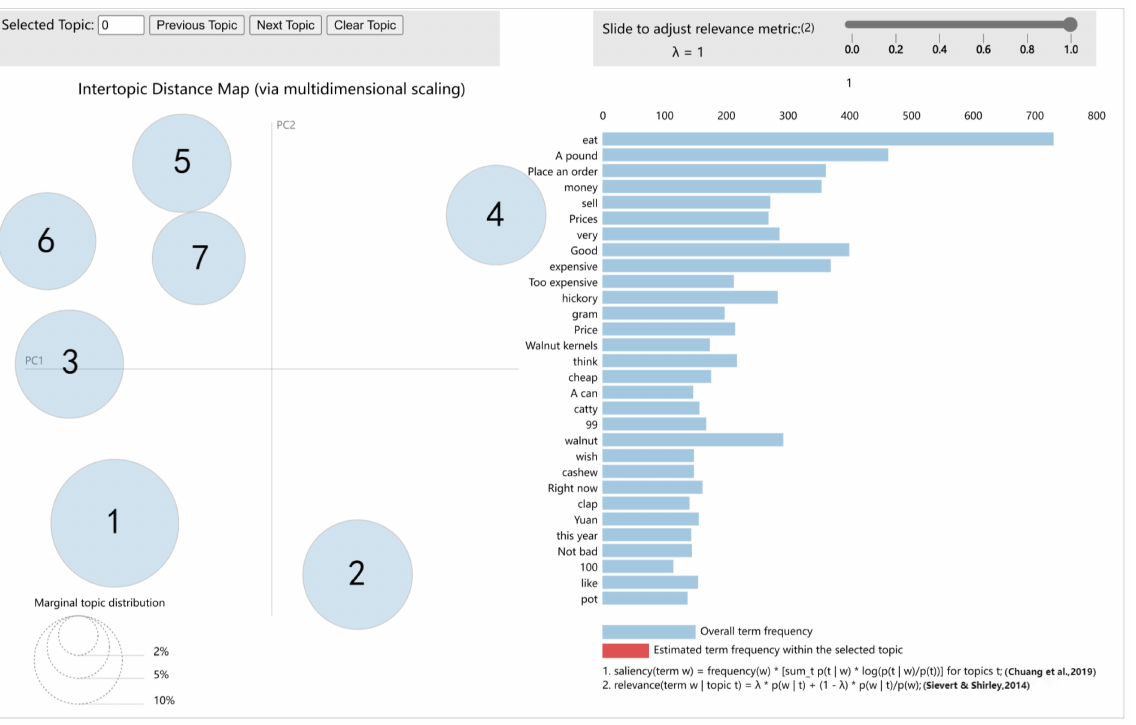
Figure 5. Best topic visualization. (In the figure, formula 1 refers to the literature [35], formula 2 refers to the literature